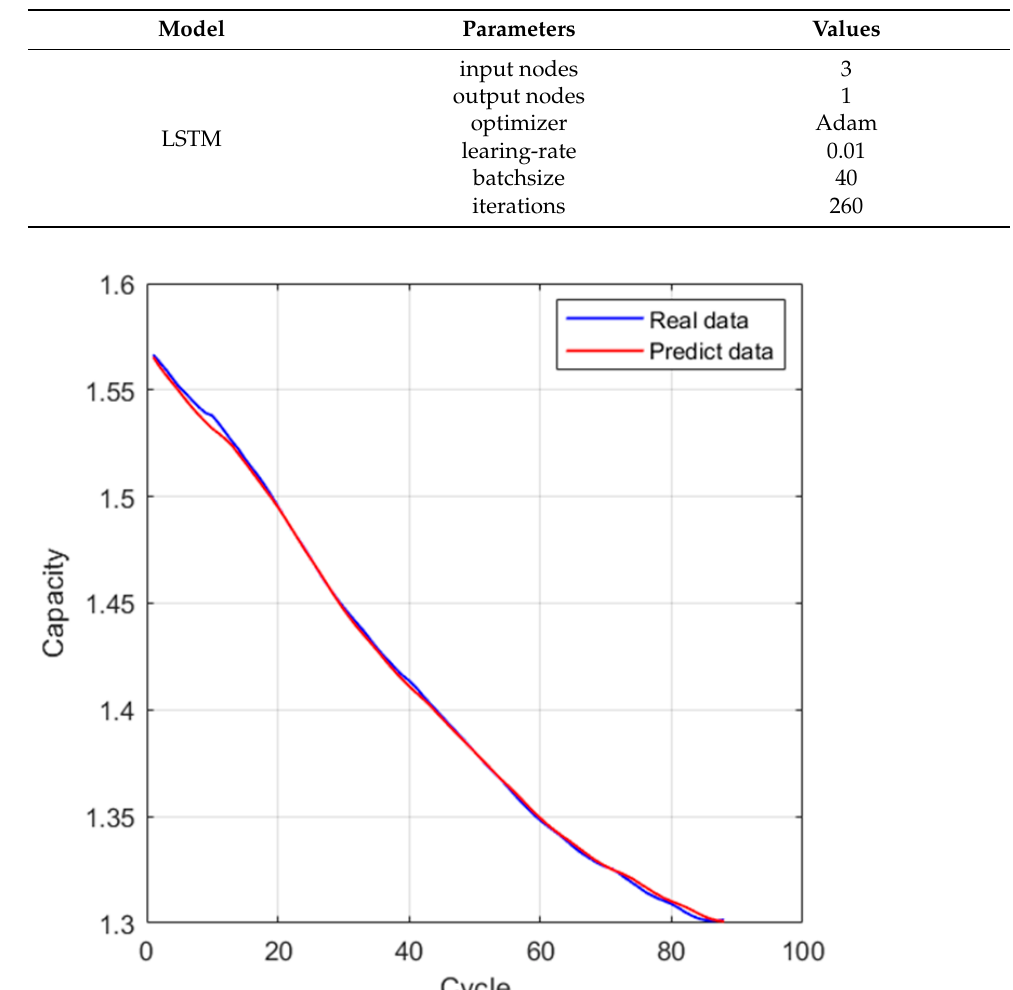
Table 4. Parameters and structure of LSTM.